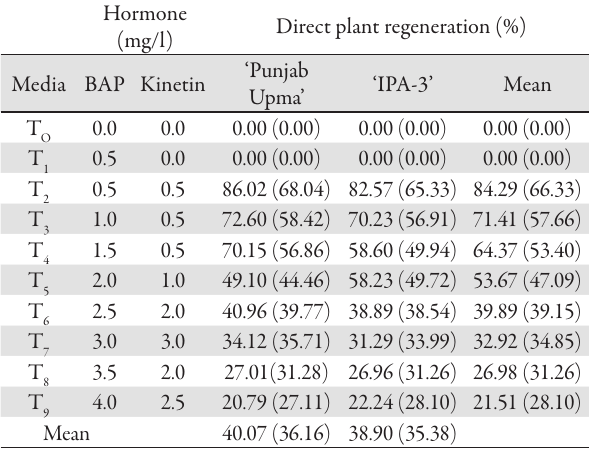
Tab. 2 . Average number of shoots from hypocotyl explants